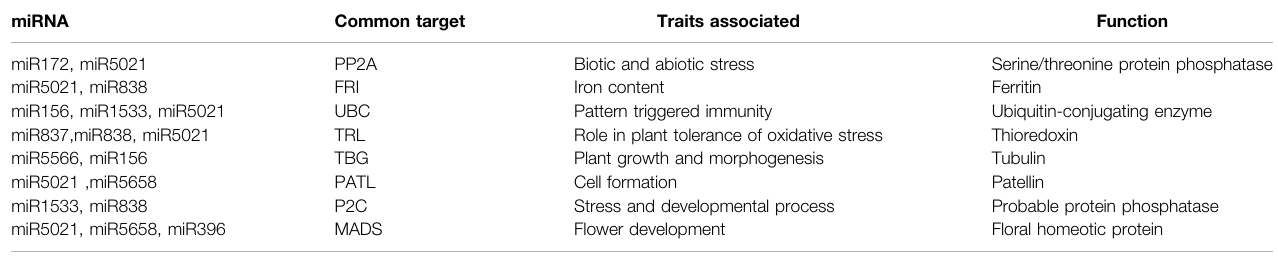
TABLE 3 | Common targets of predicted miRNA families in cluster bean